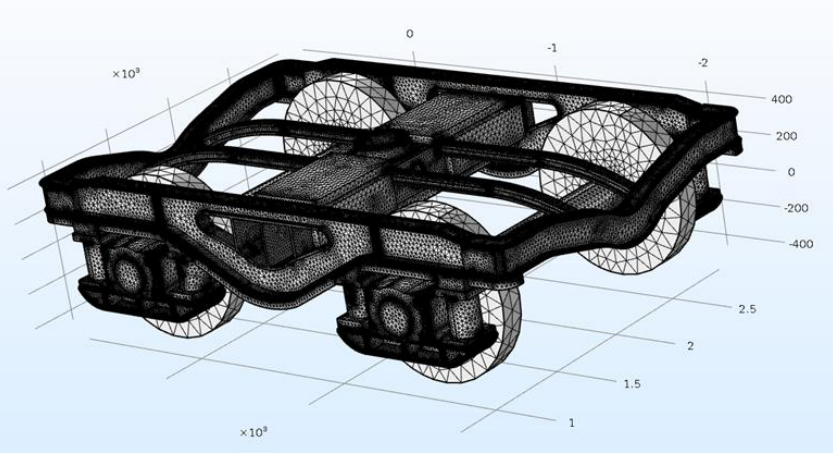
Figure 6. A mesh model of the Y25 bogie with insulation prepared in the COMSOL Multiphysics program.